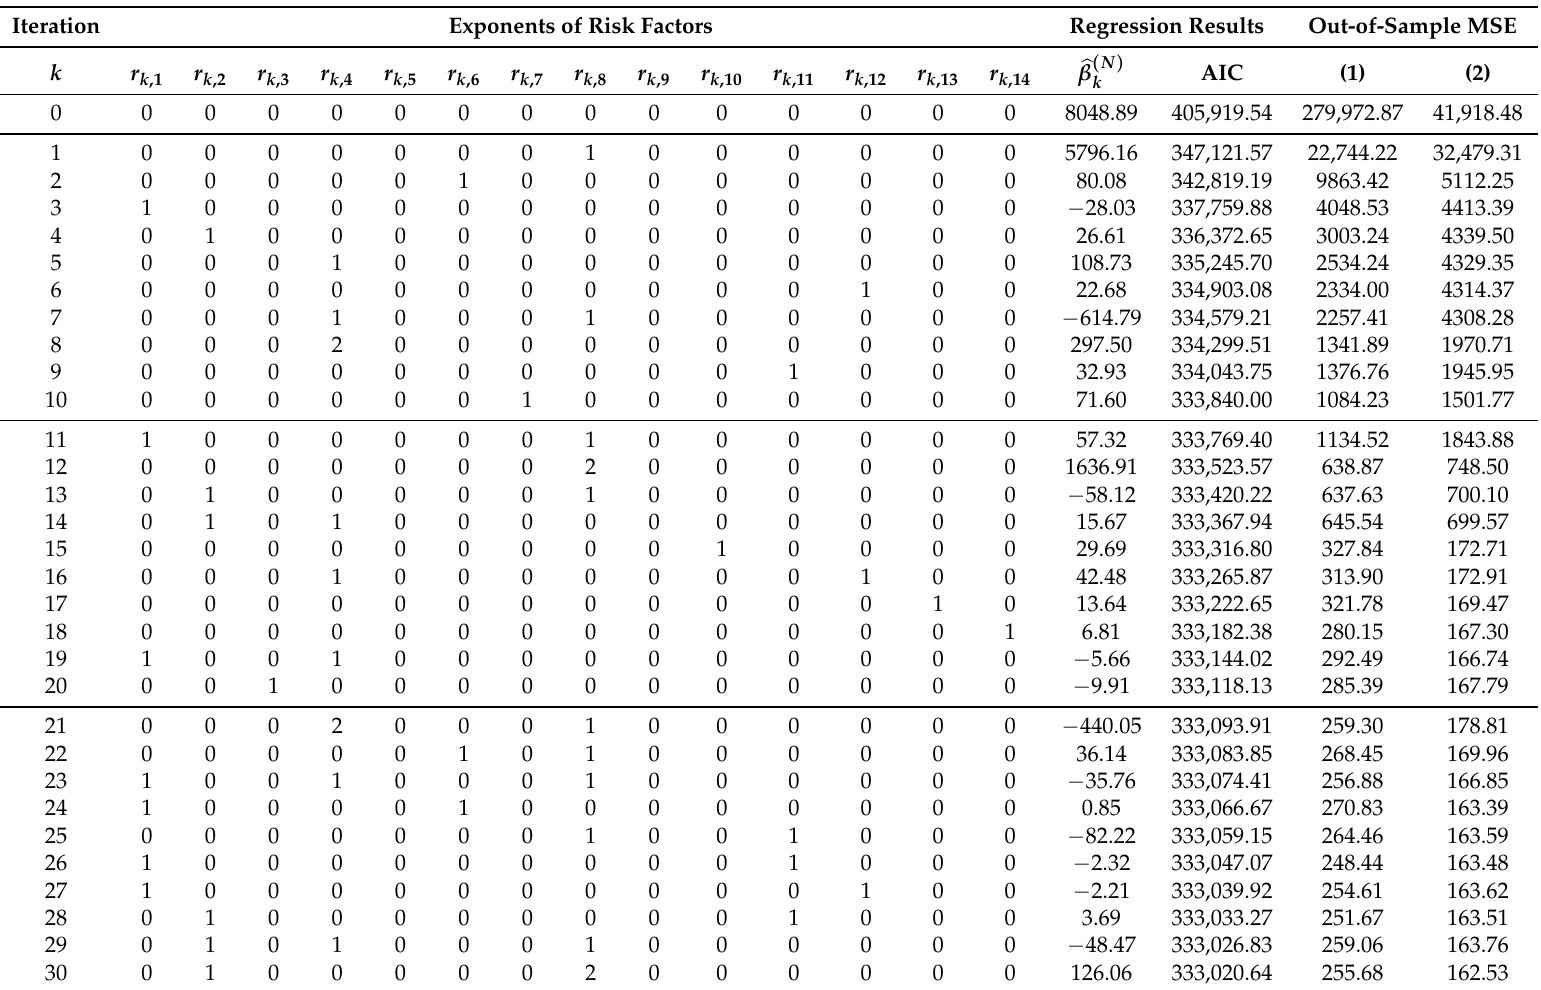
Table 2. Construction sequence of the proxy function in the adaptive algorithm with the final coefficients. Furthermore, AIC and out-of-sample mean squared errors after each